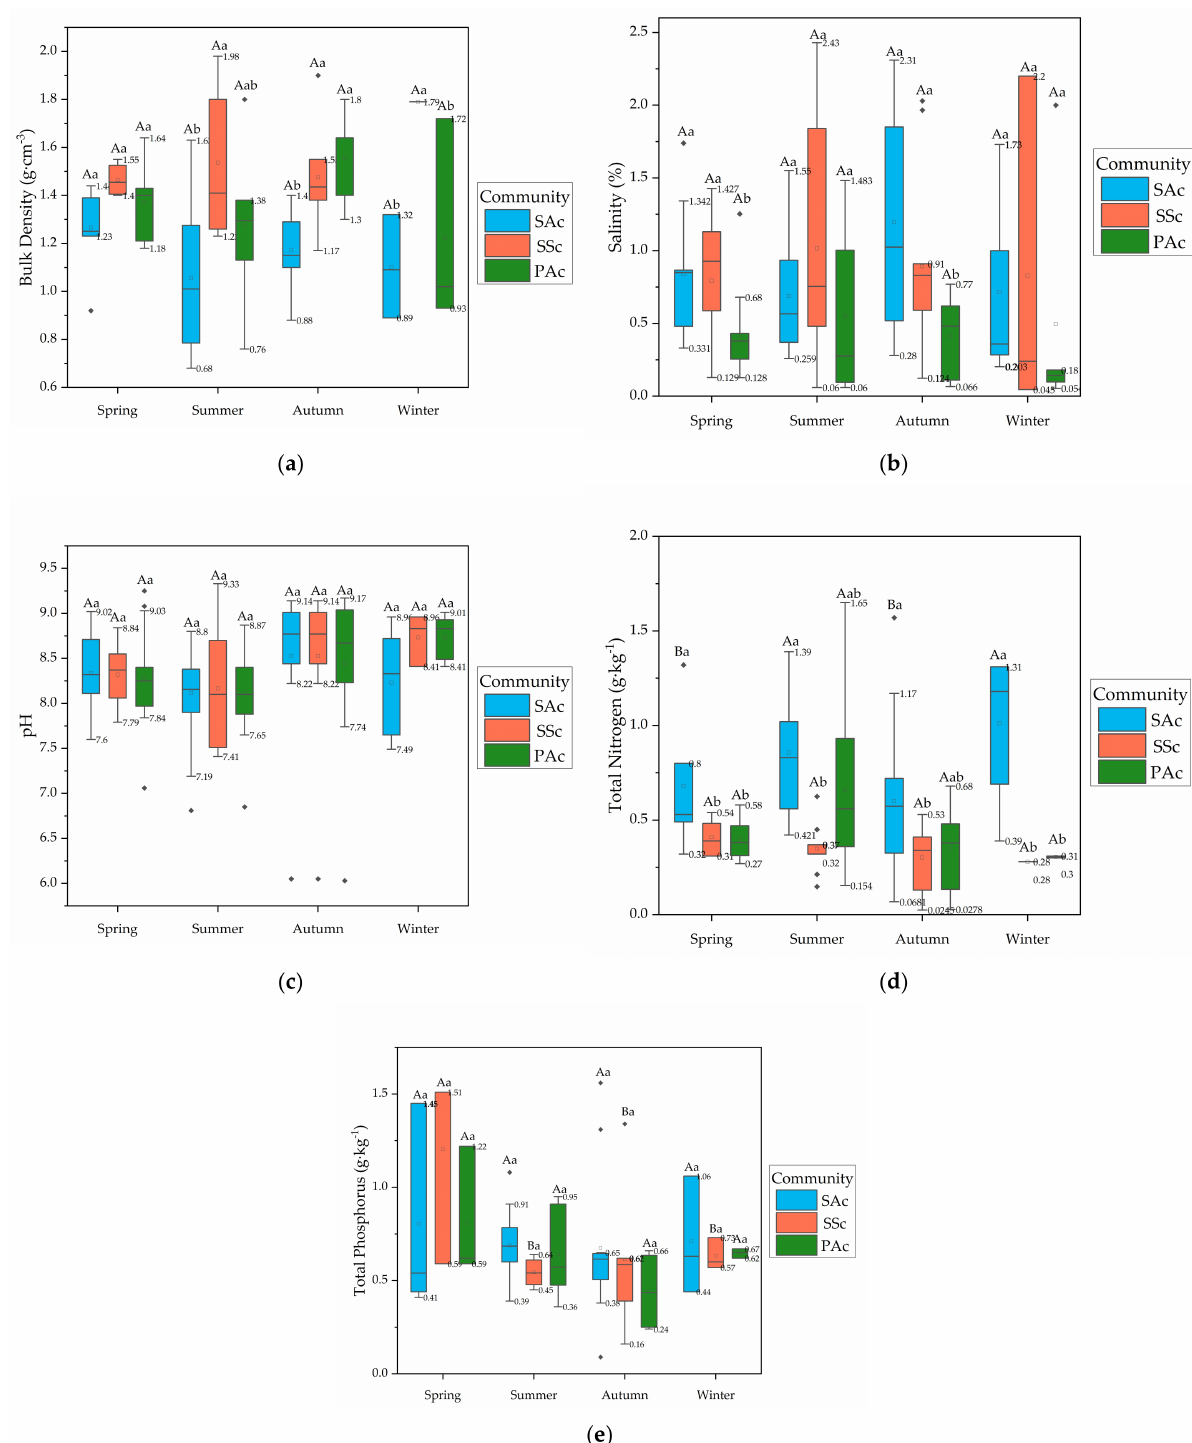
Figure 3. Box plots of the differences in soil factors corresponding to the three communities by season: ( a ) bulk density; ( b ) salinity; ( c ) pH; ( d ) TN; and ( e ) TP. Different colors represent different communities. Boxes show the 25th and 75th percentiles and medians (thick lines), while staples indicate the smallest and highest values (excluding outliers). Outliers are shown as solid circles. The range of whiskers is marked in the figure. Lowercase letters indicate the significance of differences between communities in the same season, where “a, b” indicates significant difference among the three communities ( p < 0.05) Capital letters indicate the significance of differences between seasons in each community, where “A, B” indicates significant difference among the four seasons ( p <